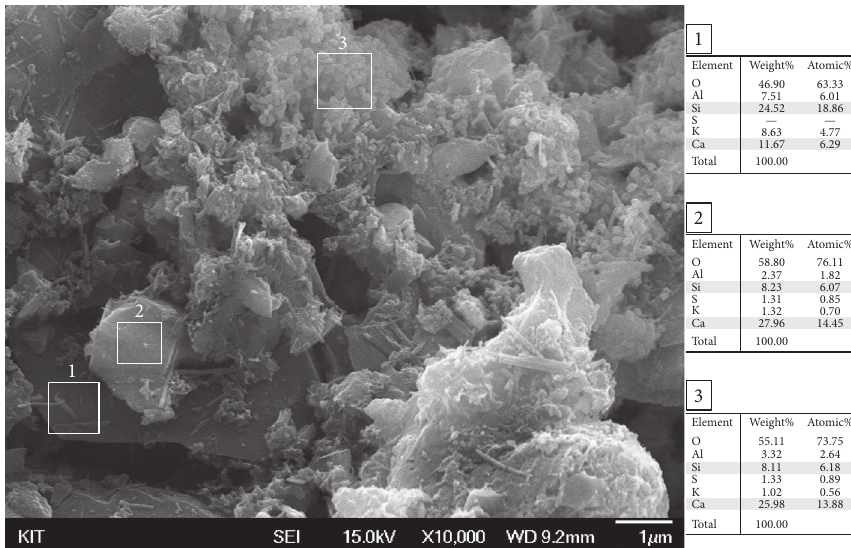
Figure 11: SEM view and chemical detected property by EDX of LGP12 10% (3 days).